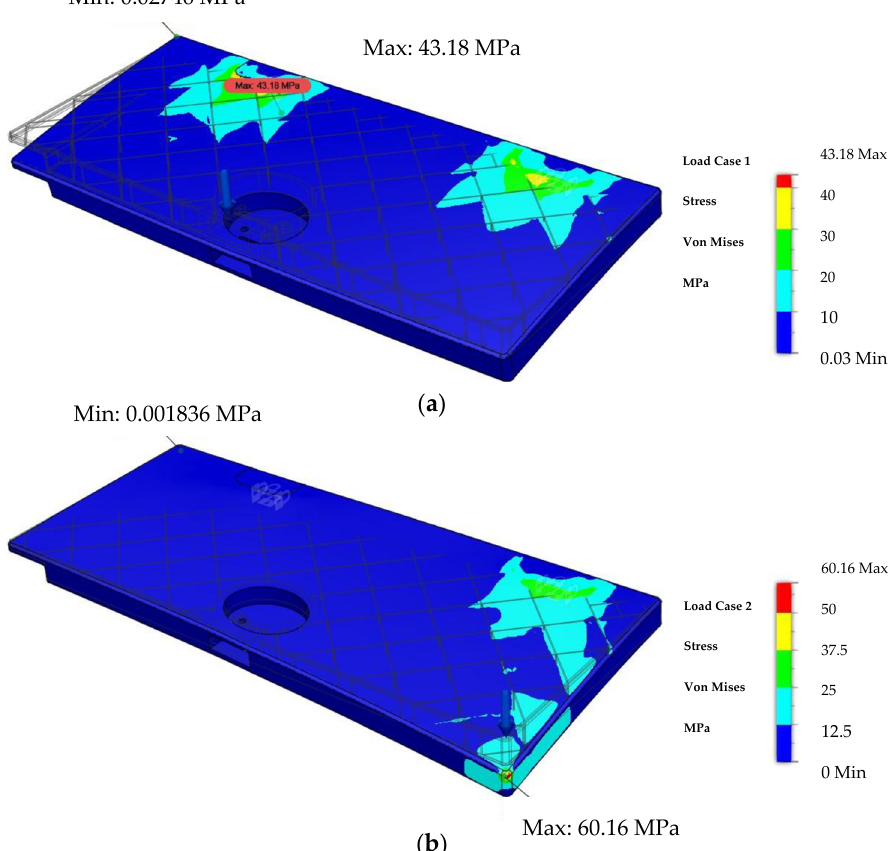
Figure 14. Von Mises stress distribution under the load of 900 N, subjected in the middle of the test sample ( a ), and under the load of 500 N, applied on the edge of the test sample ( b ).